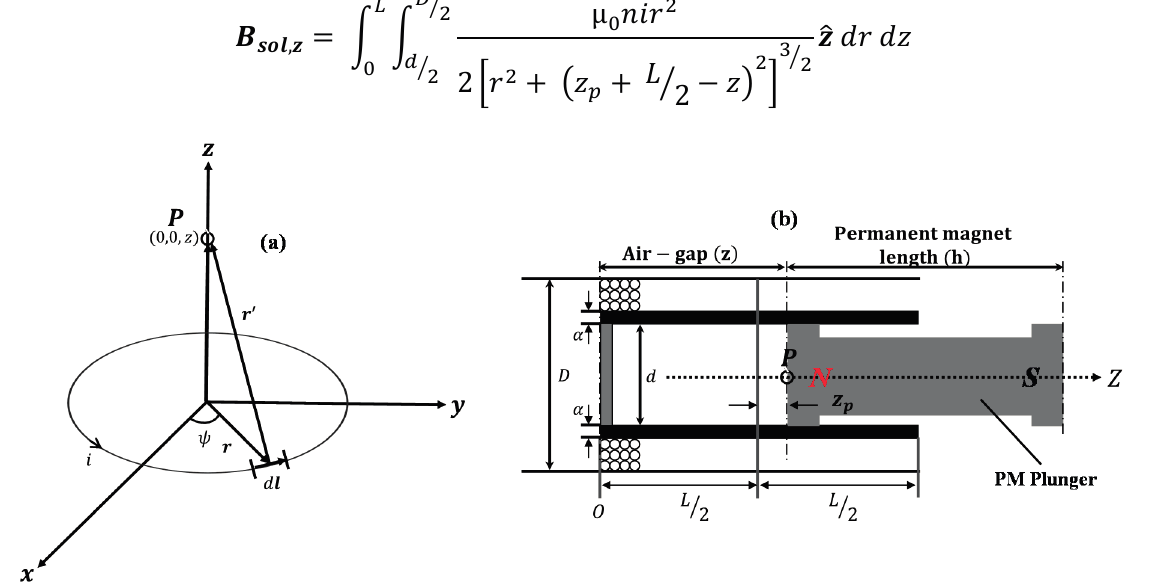
Figure 2. The solenoid dimensions for the electromagnetic analysis: ( a ) one turn of coil flowing with current i ; ( b ) the cross-sectional view of a solenoid with PM plunger and design